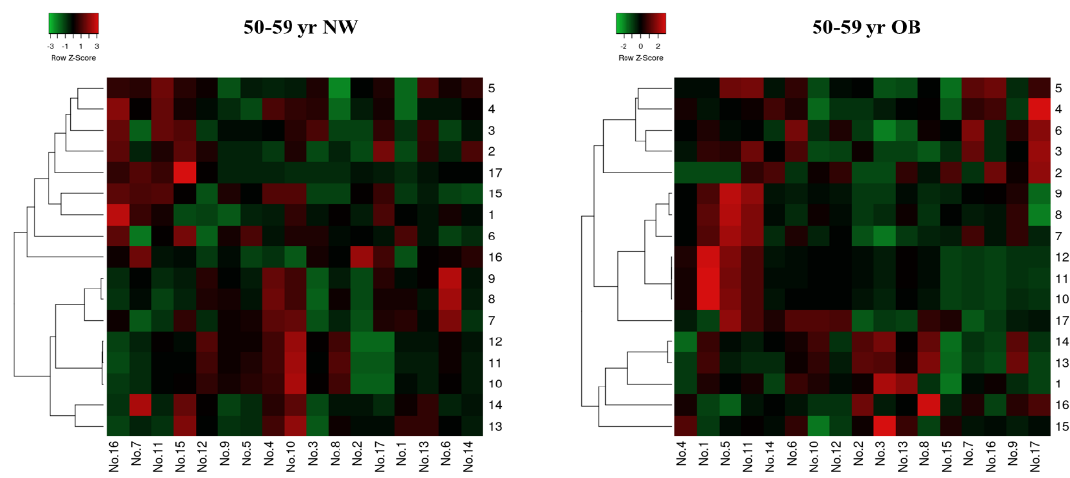
Figure 3. Heatmap of raw data (normalized to mean or median) and correlation of all the outcomes in the NW and OB groups. The colour red and green are representing the negative and positive correlations, respectively. Symbol: NW, normal weight; OB, obesity; blood leukocyte relative telomere length = 1; age = 2; body mass index = 3; waist circumference = 4; body fat (%) = 5; fat-free mass = 6; RMR AB , absolute resting metabolic rate = 7; RMR BM , resting metabolic rate adjusted for body mass = 8; RMR FFM , resting metabolic rate adjusted for FFM = 9; RFO AB , absolute resting fat oxidation rate = 10; RFO BM , resting fat oxidation rate adjusted for body mass = 11; RFO FFM , . V O 2max (mL/kg BM/min), maximum resting fat oxidation rate adjusted for fat-free mass = 12; . V O 2max (mL/kg FFM/min), maximum oxygen oxygen consumption adjusted for body mass = 13; consumption adjusted for fat-free mass = 14; MDA, malondialdehyde = 16; hsCRP, high-sensitivity C-reactive protein = 17.